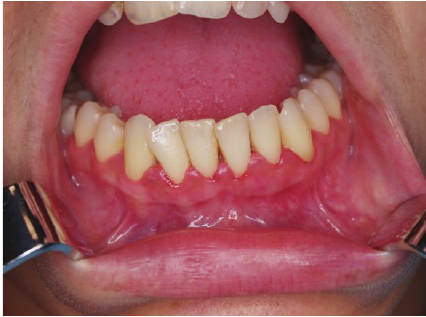
Figure 4: Clinical image of the lower anterior gingiva 3 weeks after CO 2 vaporisation procedure without